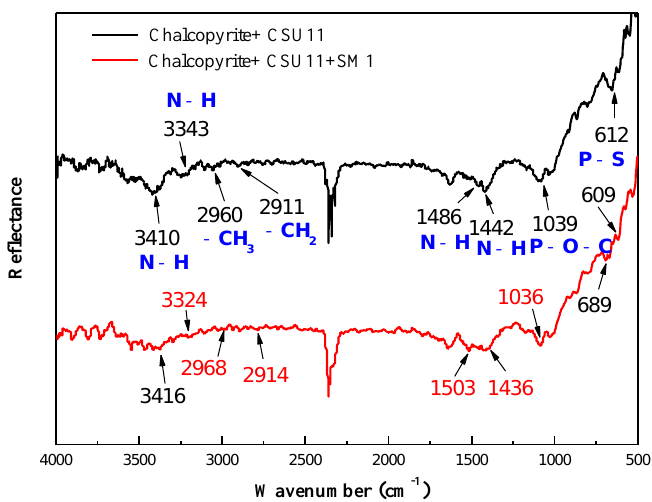
Figure 10. FT-IR spectra of chalcopyrite treated with the collector CSU11 and the depressant SM1 at natural pH (CSU11 concentration 50 mg/L, SM1 concentration 200 mg/L).